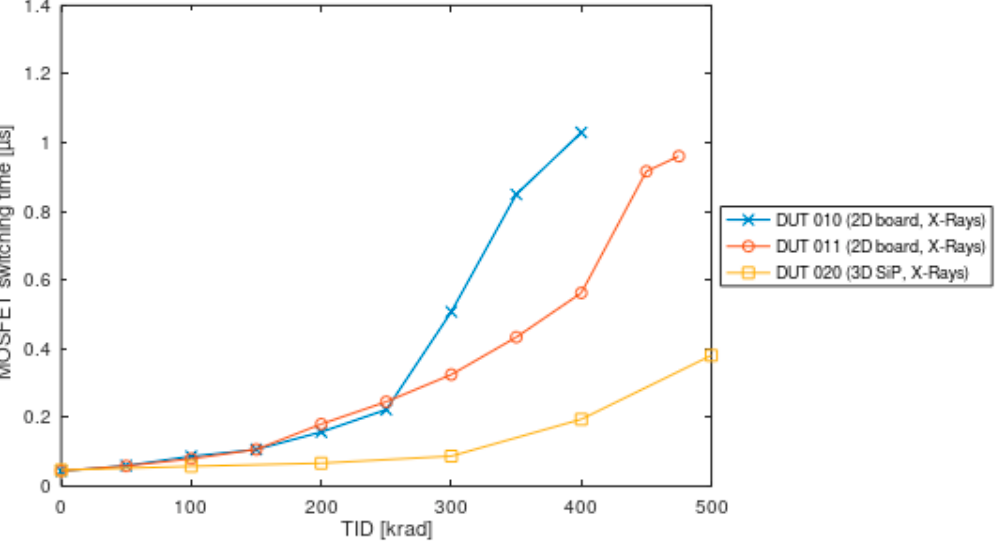
Figure 7. Switching time as a function of the total ionizing dose for both 2D boards and 3D SiP